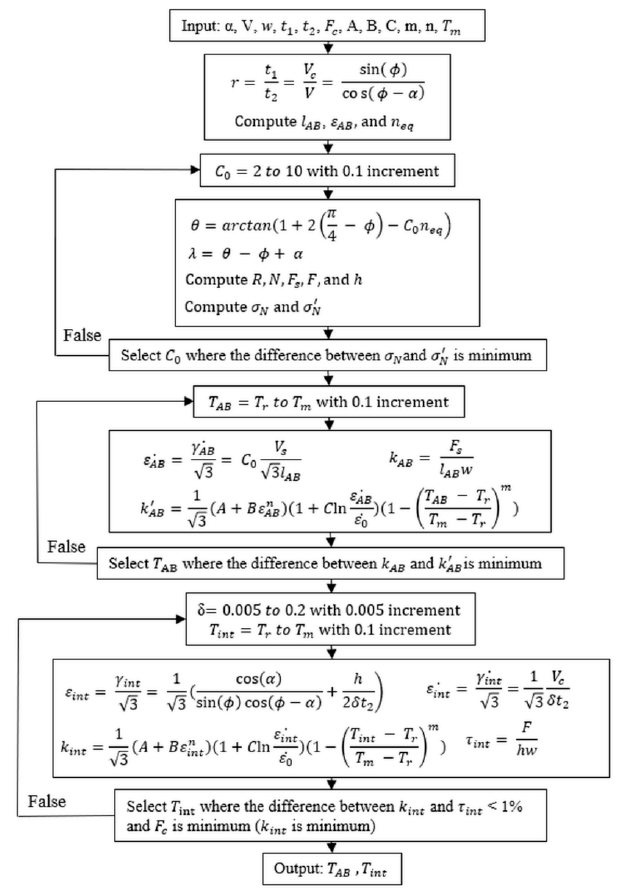
Figure 1. The algorithm of temperature prediction model based on Johnson-Cook (J-C) model and chip formation model [24].